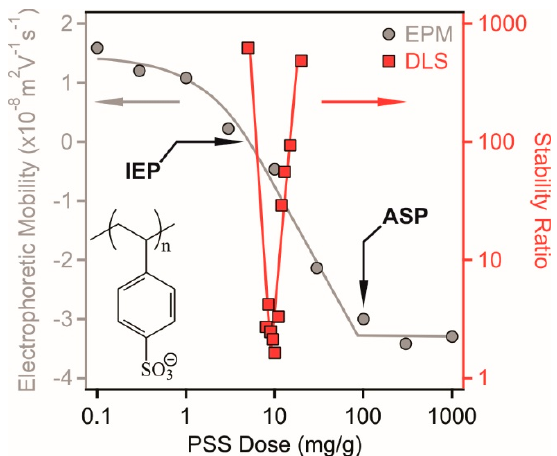
Figure 2. Electrophoretic mobility (circles, left axis) and stability ratio (squares, right axis) values of LDH particles in the presence of PSS polyelectrolyte. The measurements were carried out at 10 mg/L particle concentration and 10 mM NaCl was used as background electrolyte to adjust the ionic strength. The mg/g unit on the x-axis refers to mg PSS per one gram of LDH. The structure of PSS is shown in the inset.